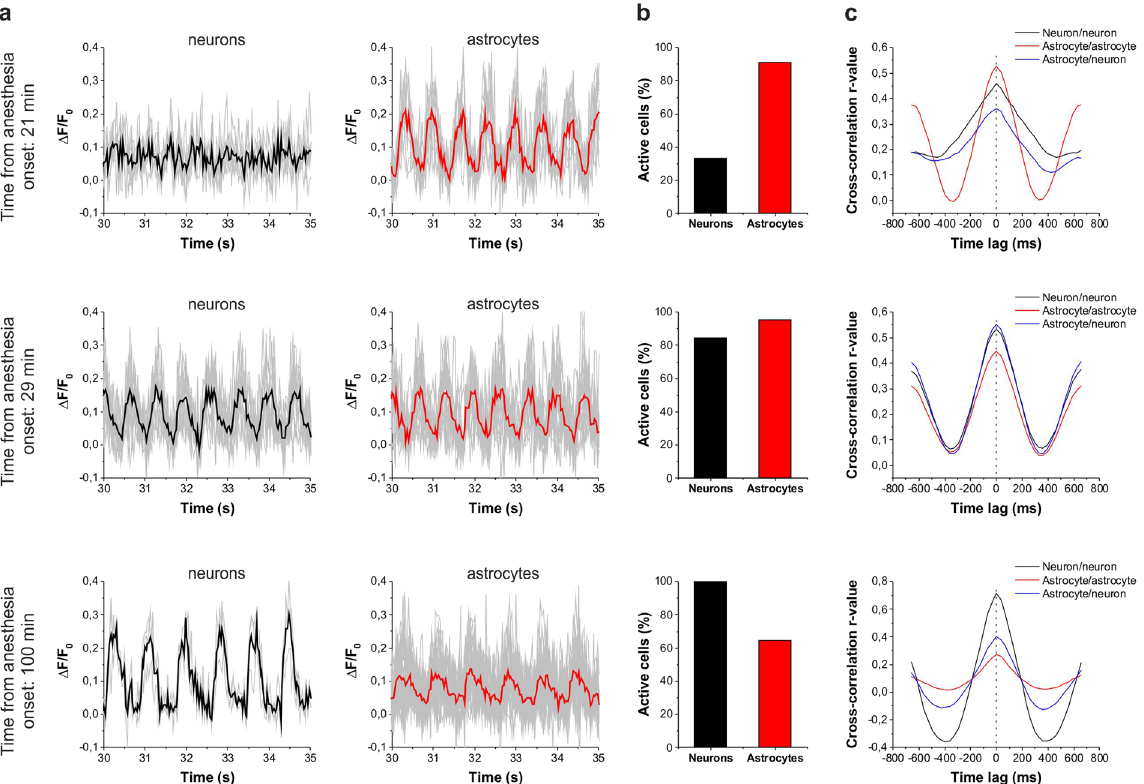
Figure 4. Astrocytes are more broadly involved in SWA than neurons in the early stage of ketamine/xylazine anesthesia. ( A–C ) Changes in the involvement of neurons and astrocytes in the network activity during SWA under ketamine - xylazine anesthesia after 21 min, 29 min and 100 min from the onset of anesthesia. ( A ) Fluorescent intensity changes detected in neurons and SR101-identified astrocytes. Individual Ca 2 + traces (gray) and their averages in neurons (black) and astrocytes (red) are shown on 5-sec segments of the imaging sessions at each time point. ( B ) The ratio of neurons (black) and astrocytes (red) showing repetitive Ca 2 + transients in percentage of all astrocytes or neurons, respectively, in the field of view in this particular imaging session. ( C ) Cross-correlation of neuron/neuron (black), astrocyte/astrocyte (red) and astrocytes/neuron (blue) pairs of active cells (n = 12–420 cell pairs). All data were recorded from the V1 area of a P78